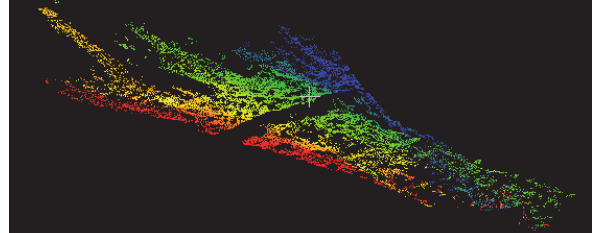
Figure 4. Decimated ground points from a patch. The backpack occludes downwards scanning which can be seen as a linear gap in the middle of the